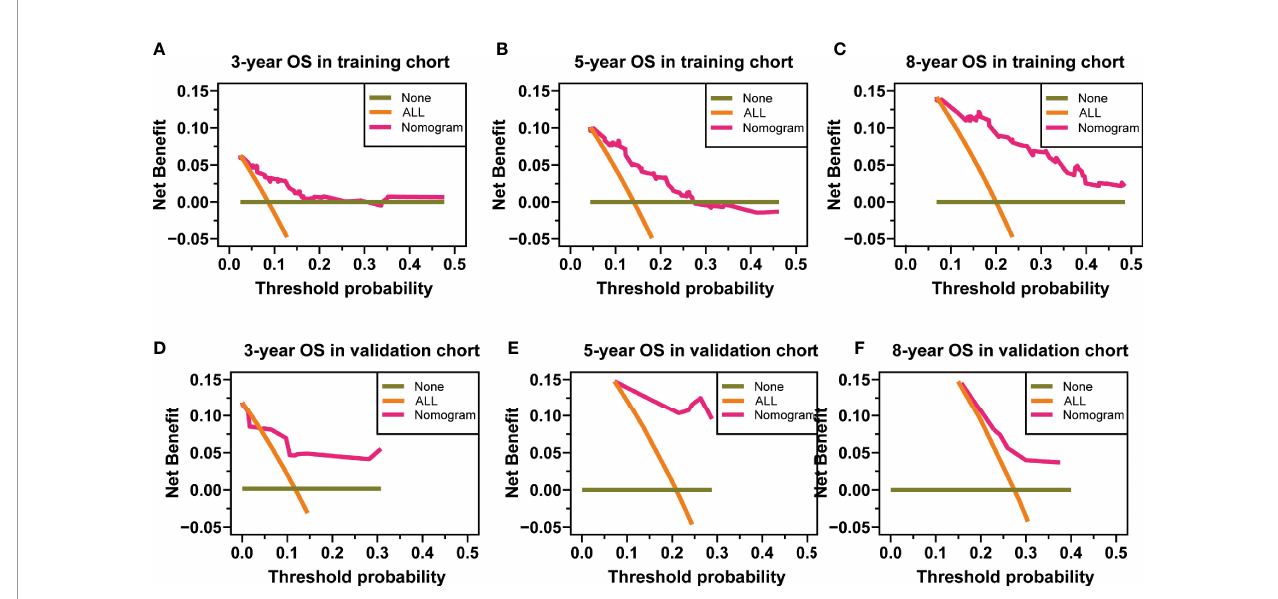
FIGURE 6 | Decision curve analysis at 3, 5, and 8 years in the training set for the overall survival (OS) prediction nomogram (A – C) . Decision curve analysis at 3, 5, and 8 years in the validation set for the OS prediction nomogram (D – F)